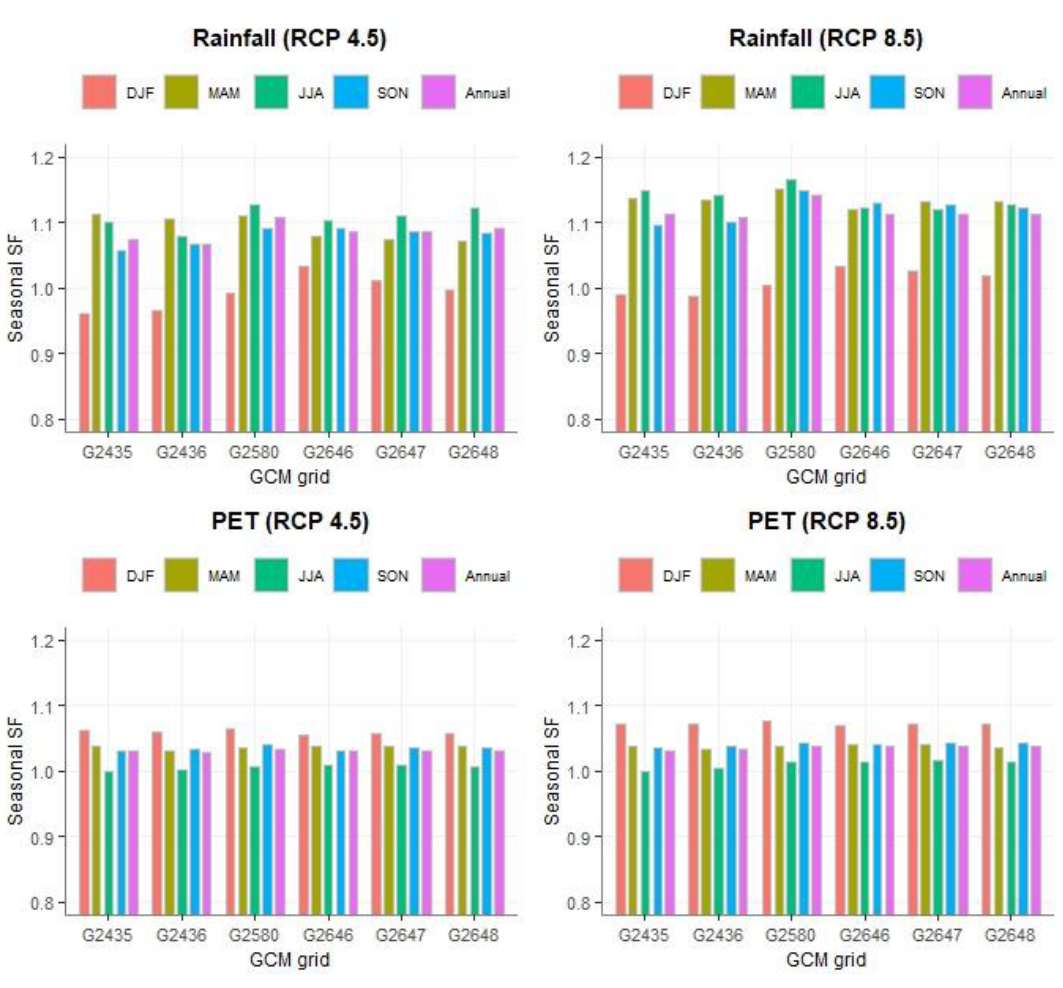
Figure 10. Variations of seasonal scaling factor of rainfall ( upper panels ) and PET ( lower panels ) across the northwest region (DJF: Dec-Jan-Feb, MAM: Mar-Apr-May, JJA: Jun-Jul-Aug, SON: Sep-Oct- Nov).